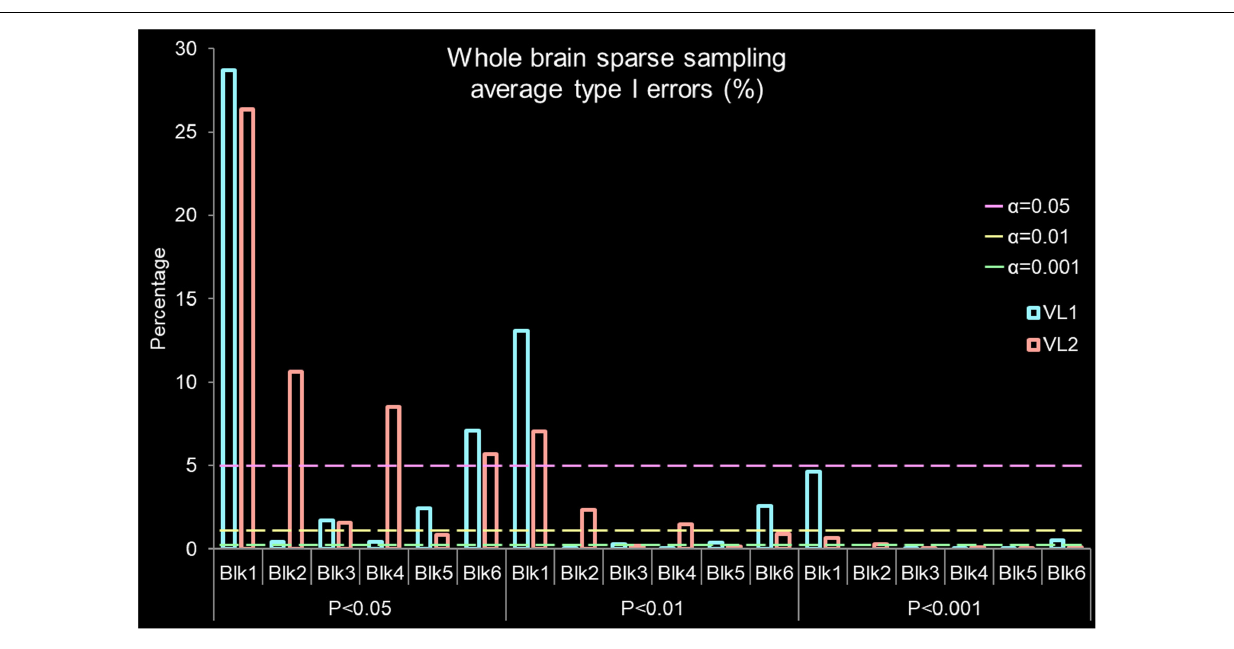
FIGURE 3 | Whole brain sparse sampling of silence average type I error percentage derived from activation/deactivation maps ( Figure 2a ). The bars are observed type I errors from the blocks grouped by P -values. The x-axis is grouped volume, represented by VL1 (#98f5ff cadet blue) or VL2 (#ffa298 Salmon pink), by P -values ( P < 0.05, P < 0.01, and P < 0.001) and by block (Blk). The y-axis is percentage of false positives found if accepting a specific alpha ( α ) value where the lines represent α = 0.05 (#ff98f5 light magenta), α = 0.01 (#f5ff98 light yellow), and α = 0.001 (#98ffa2 light green). The expected type I error rate α is found by dashed lines for α = 0.05, α = 0.01, and α = 0.001. Above these lines for an accepted P -value, a type I error has been committed. Therefore, rejecting the null hypothesis (indicating there is a difference) when no relevant BOLD activation/deactivation is